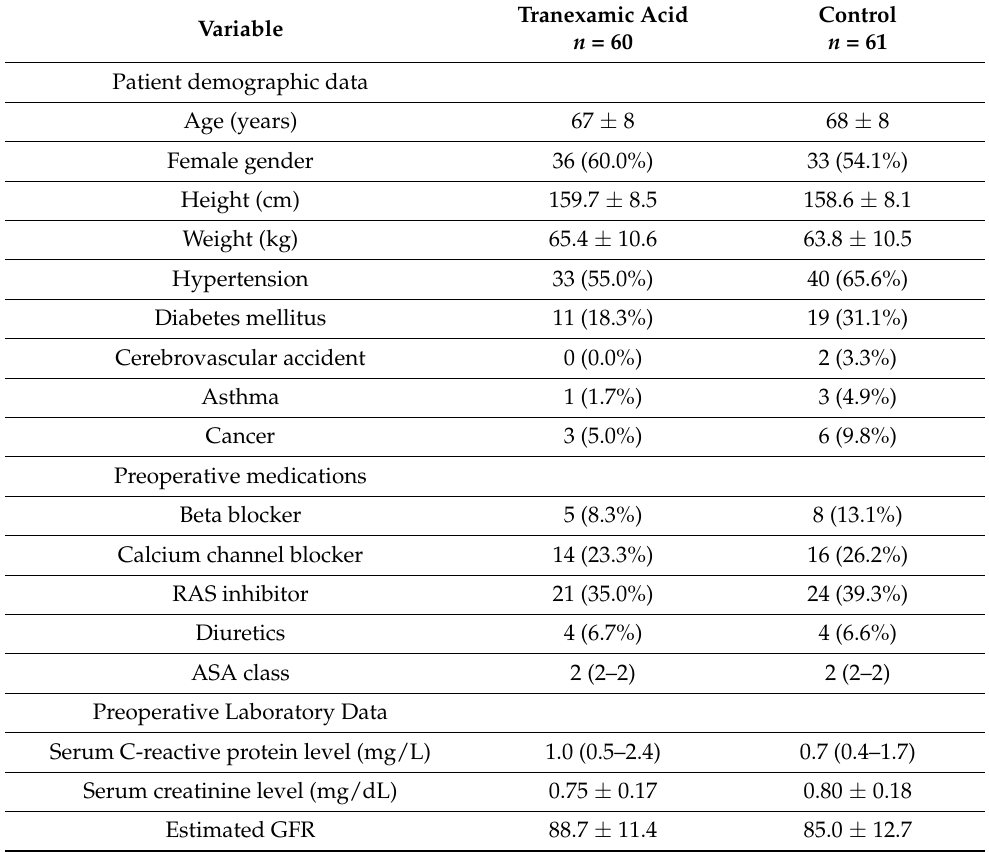
Table 1. Baseline characteristics and intraoperative